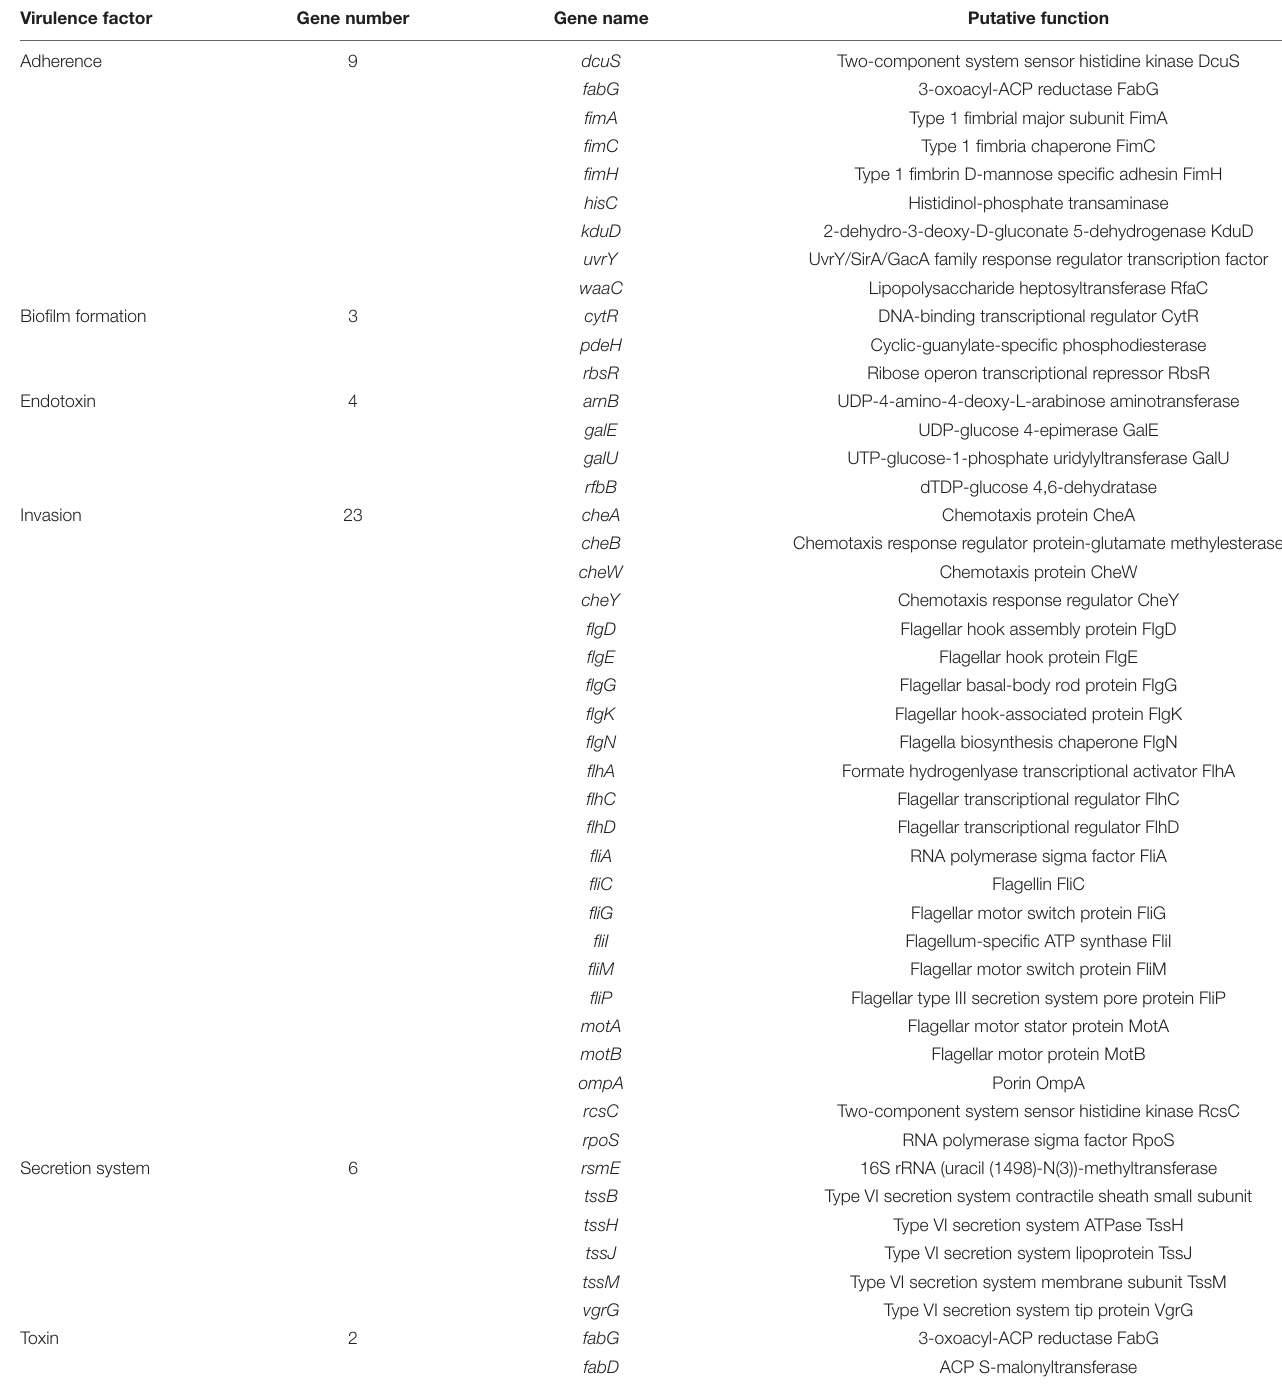
TABLE 3 | Potential virulence-related genes in strain Pa82 genome predicted by VFDB. Virulence